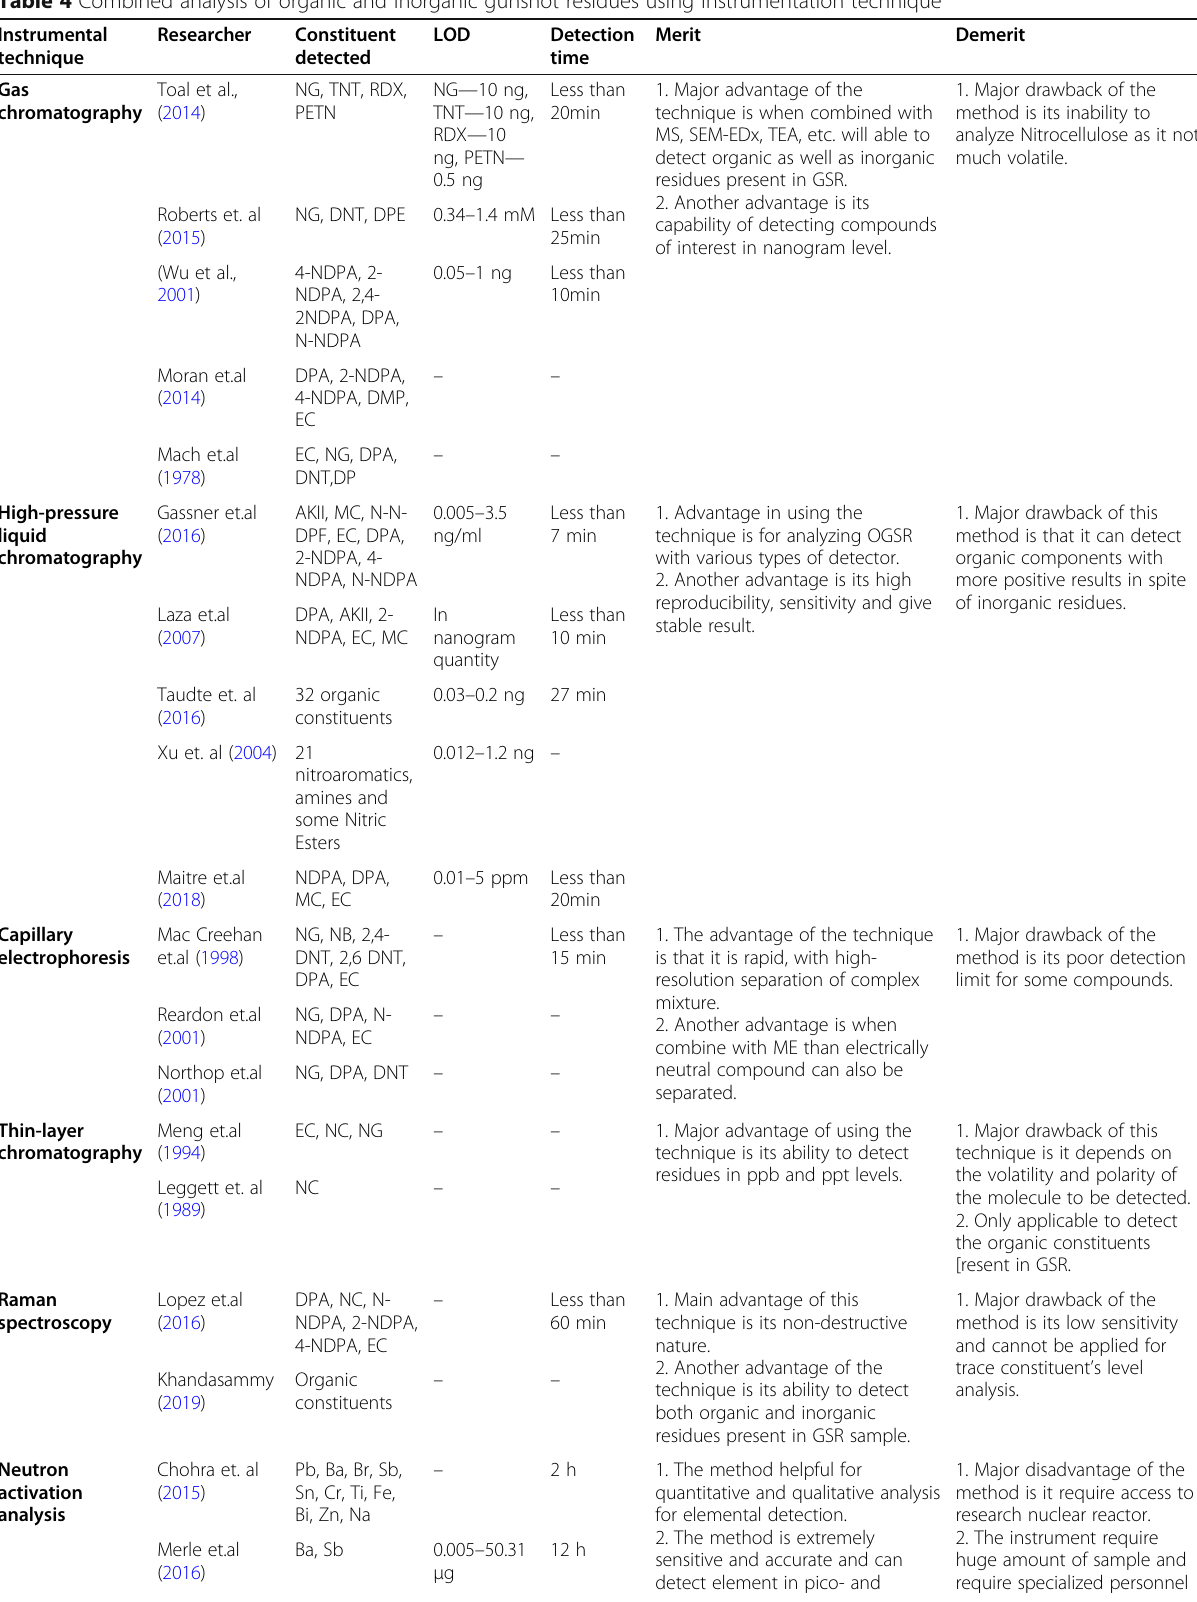
Table 4 Combined analysis of organic and inorganic gunshot residues using instrumentation technique Instrumental